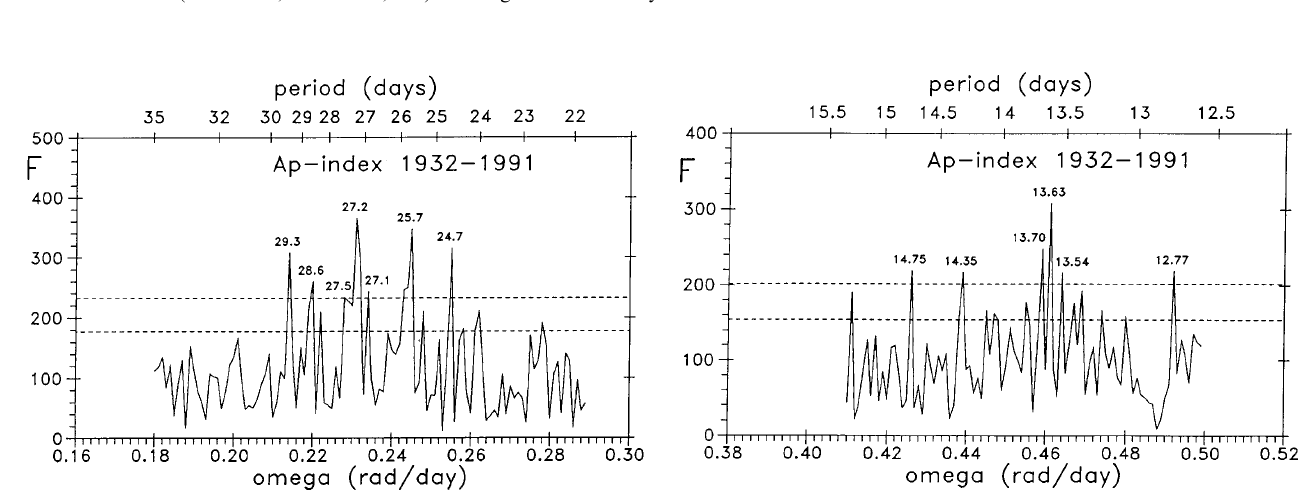
Fig. 5. Spectrum of geomagnetic Ap -indices in the whole interval 1932–1991 in the vicinity of the 13.6-day period. Horizontal dashed lines indicate the 95% and 99%